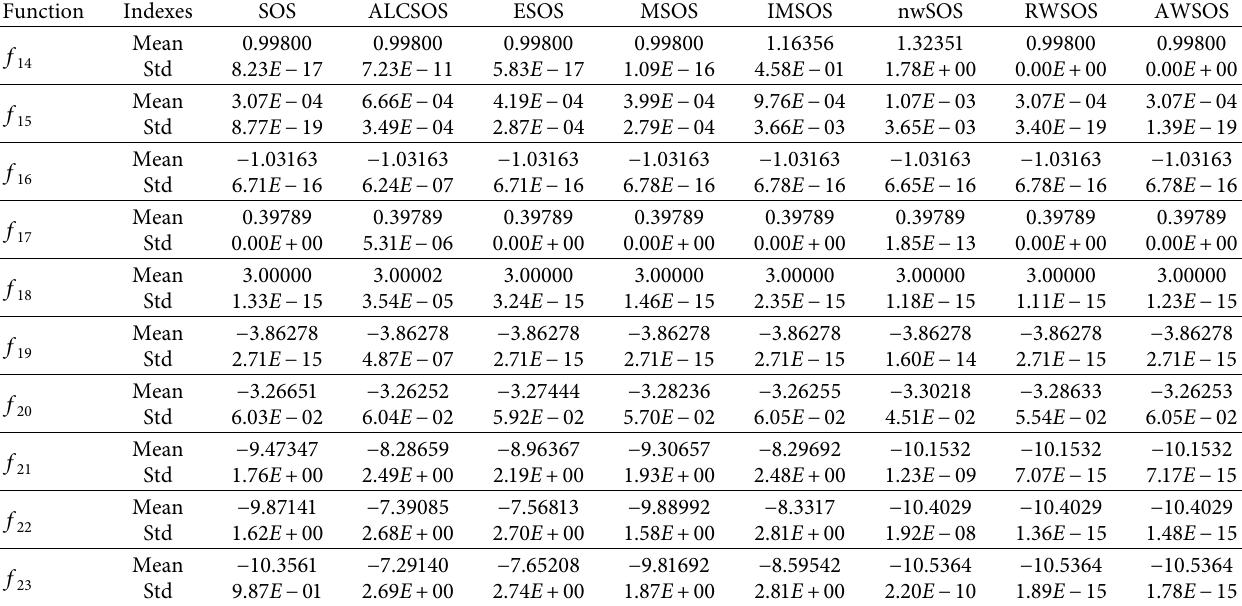
Table 13: Results of the SOS and variants on fxed-dimension multimodal